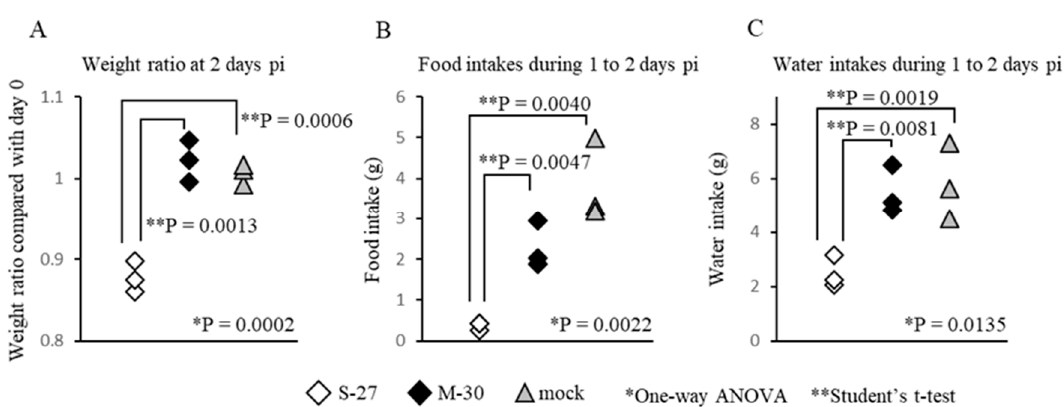
Figure 3. ( A ) The ratio of weight change, ( B ) food intakes, ( C ) water intakes for individual AG129 mice following subcutaneous infection with high titer 10 5 PFU M-30 and S-27 CHIKV strains. The asterisks show significant differences by one-way ANOVA (*) and by the Student’s t-test (**), P < 0.05.